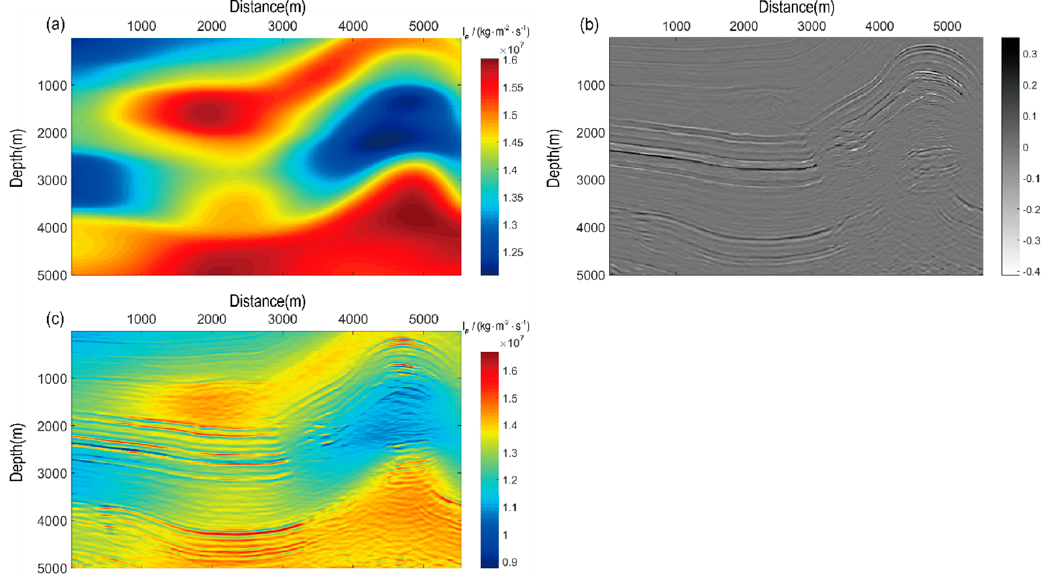
Figure 8. The background AI model of a field data ( a ), the broadband reflectivity generated from the proposed imaging method with PSF correction ( b ) and the inverted absolute AI result of the proposed AI inversion ( c ).